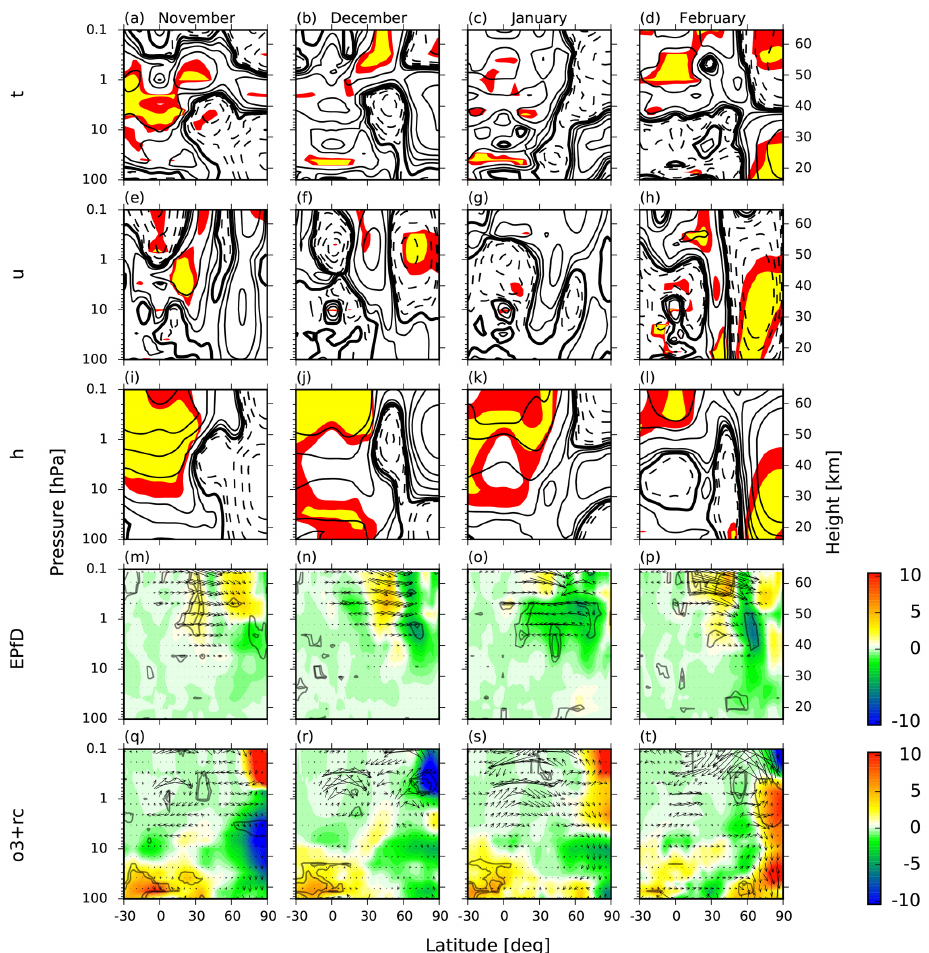
Figure 5. The monthly averaged response of the solar signal in the MERRA zonal-mean temperature t (a–d) , unit: K, contour levels: 0, ± 0 . 25, ± 0 . 5, ± 1, ± 2, ± 5, ± 10, ± 15, ± 30; zonal wind u (e–h) , unit: ms − 1 , contour levels: 0, ± 1, ± 2, ± 5, ± 10, ± 15, ± 30; geopotential height h (j–l), unit: gpm, contour levels: 0, ± 10, ± 20, ± 50, ± 100, ± 150, ± 300; EP flux divergence EPfD (m–p) , unit: ms − 1 day − 1 ; together with EP flux vectors scaled by the inverse of the pressure, unit: m 2 s − 2 ; and ozone mixing ratio, unit: percentage change per monthly mean; with residual circulation o 3 + rc (q–t) , units: ms − 1 ; − 10 − 3 Pas − 1 during northern hemispheric winter. The response is expressed as a regression coefficient (corresponding units per S max minus S min ). The statistical significance of the scalar fields was computed by a t test. Red and yellow areas in Panels (a–l) and grey contours in Panels (m–t) indicate p values of < 0.05 and 0.01